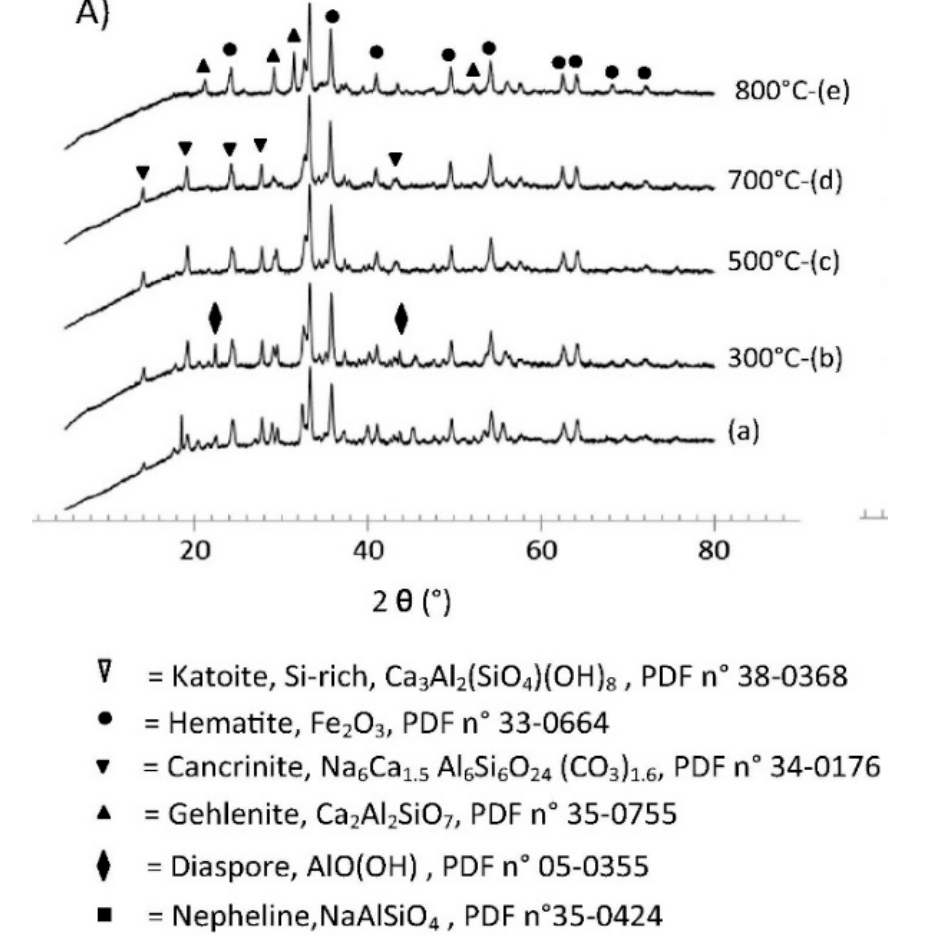
Figure 3. XRD analysis of (A) red mud